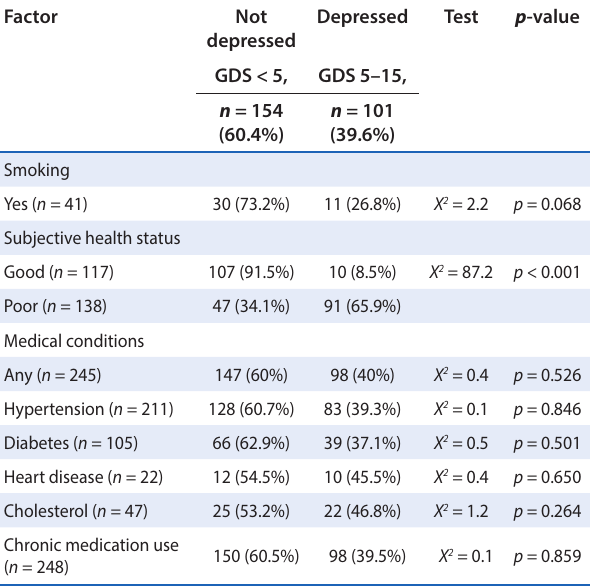
Table 2: Clinical profile of depressed vs. non-depressed participants